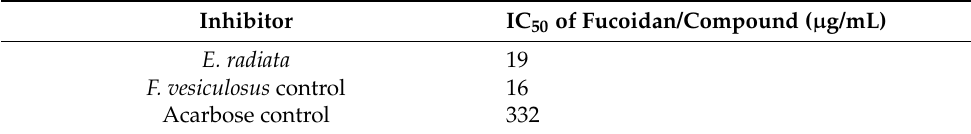
Table 2. Table showing IC 50 values of E. radiata fucoidan, F. vesiculosus commercial fucoidan and acar- bose obtained using non-linear fit (GraphPad Prism v 6) of normalised experimental α -glucosidase response to the presence of inhibitor. Values are represented as means with a SD <